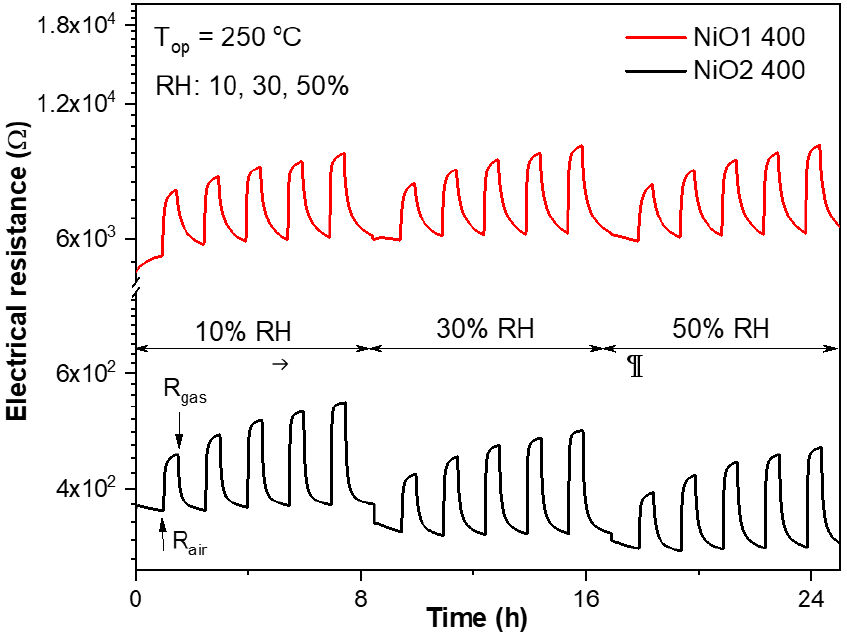
Figure 5. Electrical resistance behaviour for NiO1 400 and NO2 400 when operated at 250 °C and exposed to 10–100 ppm of CO over 10–50% RH. exposed to 10–100 ppm of CO over 10–50%